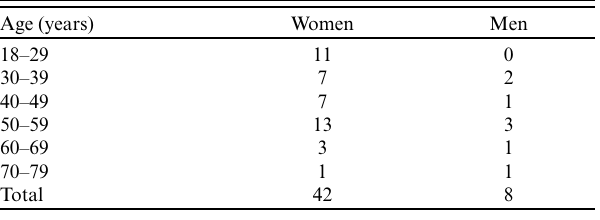
Table 2. Personal characteristics of household survey